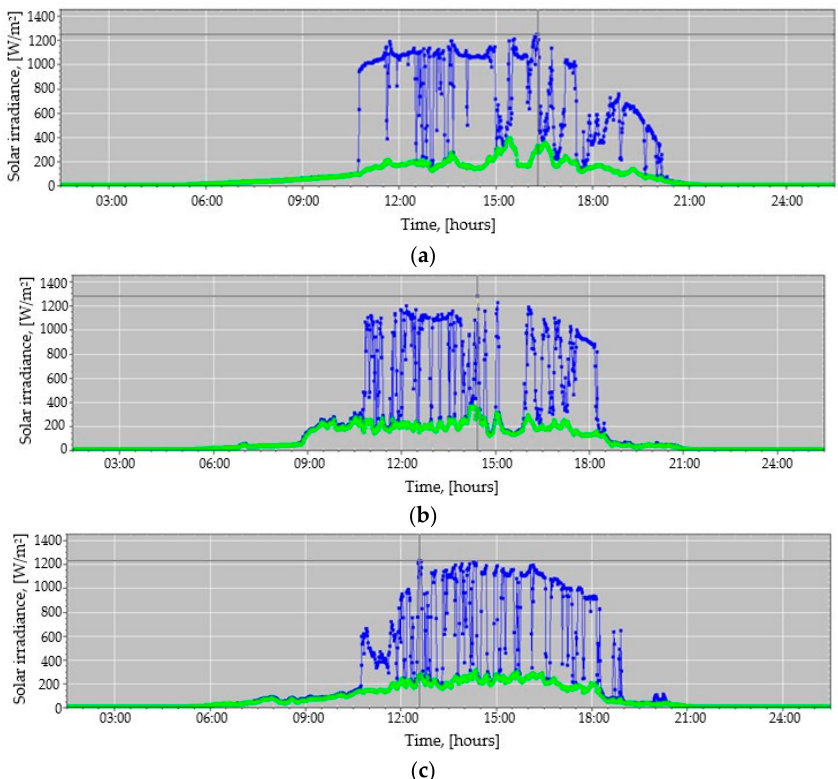
Figure 10. ( a ) Solar irradiance variations for 9 June 2022: ( -- total component; diffuse component). ( b ) Solar irradiance variations for 10 June 2022: ( -- total component; diffuse component). ( c ) Solar irradiance variations for 11 June 2022: ( -- total component; diffuse component).